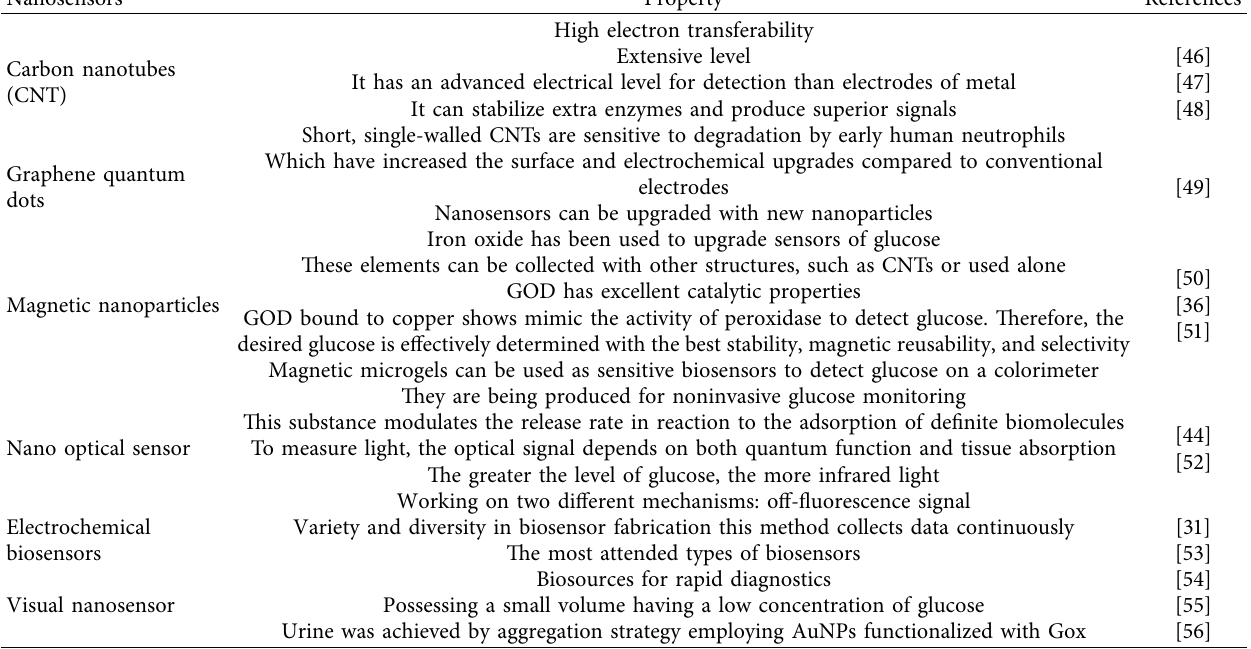
Table 1: Properties of nanomaterials used in nanosensors were examined to detect blood sugar.